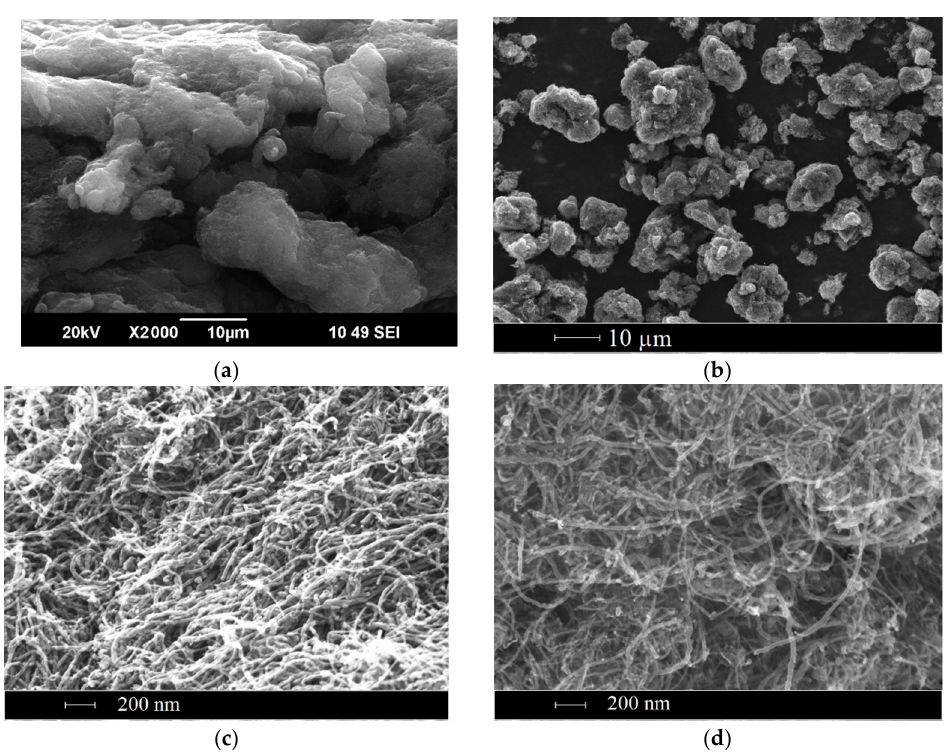
Figure 7. SEM images of initial CNTs ( a , c ) and CNTs ( b , d ) processed by RESS. Carbon and oxygen lines are observed in the XPS spectra of the samples (Figure 8).